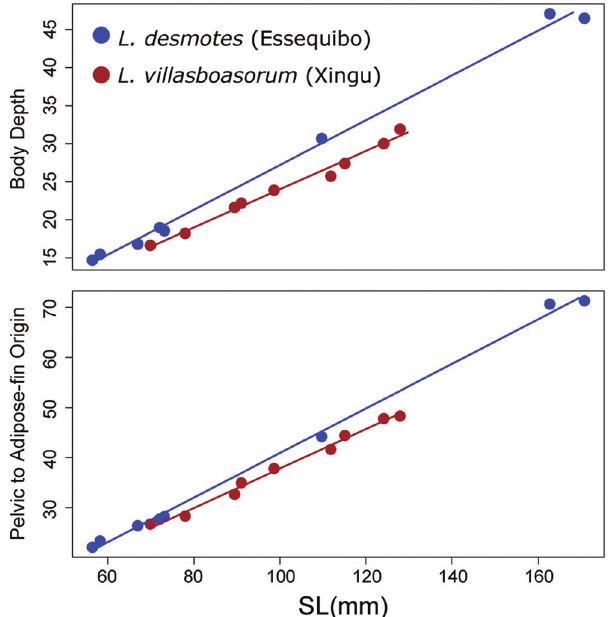
Fig. 8. Regressions of body depth and the distance between the pelvic-fin and adipose-fin origins against SL for Leporinus desmotes (blue) and L. villasboasorum (brown) showing different